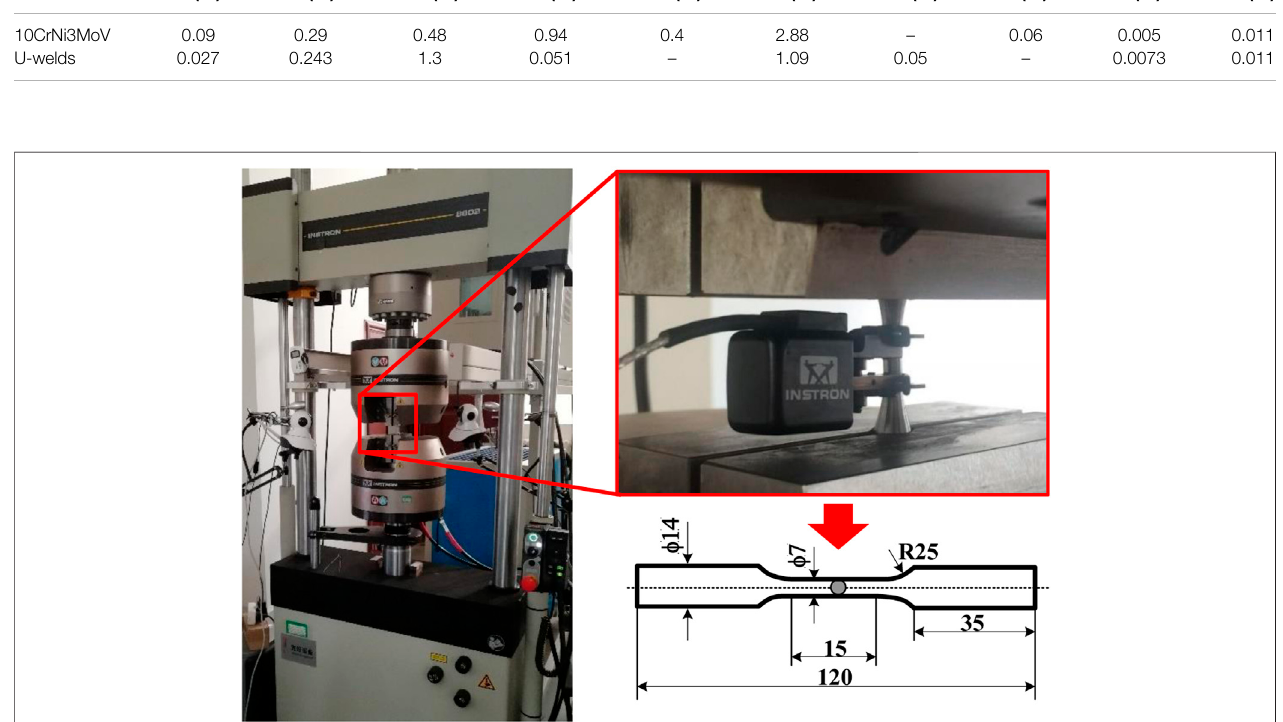
FIGURE 1 | Overview of the Instron-8802 fatigue test system and detailed specimen